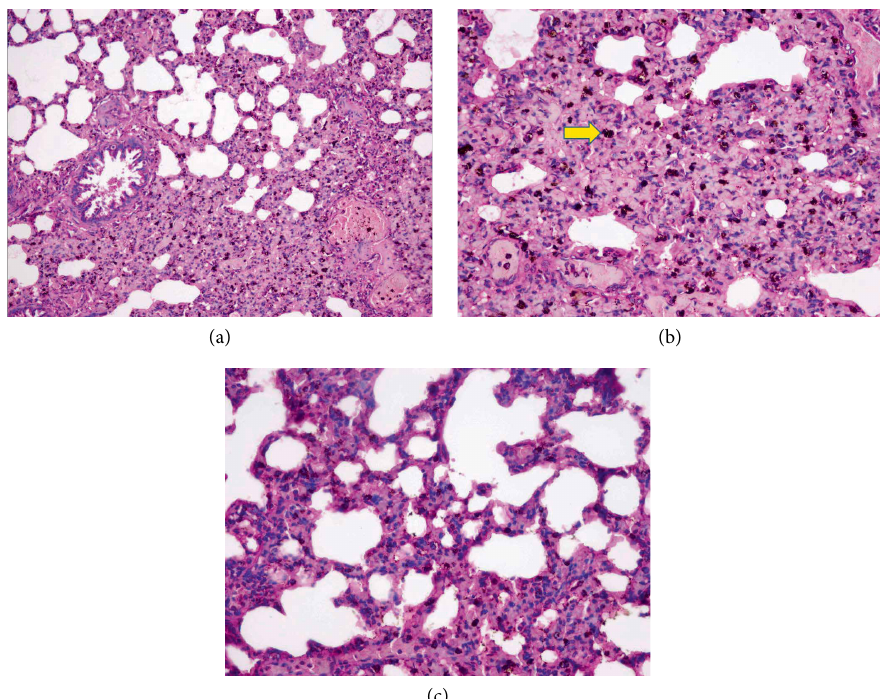
Figure 1: Lung tissue from rats that received a single dose, 2000 mg/kg of Mm-EO. (a) Abundant erythrocytes and erythrocyte residues. (b) The arrow indicates the presence of macrophages with hemosiderin. (c) Abundant inflammatory infiltrate. H&E stain and